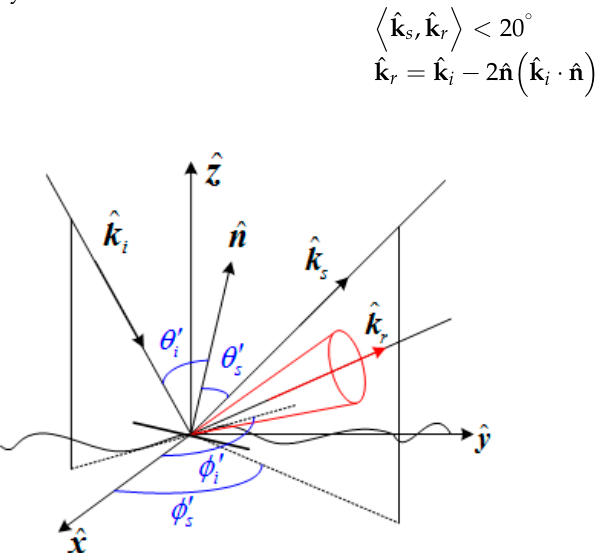
Figure 7. Schematic diagram of specular region.